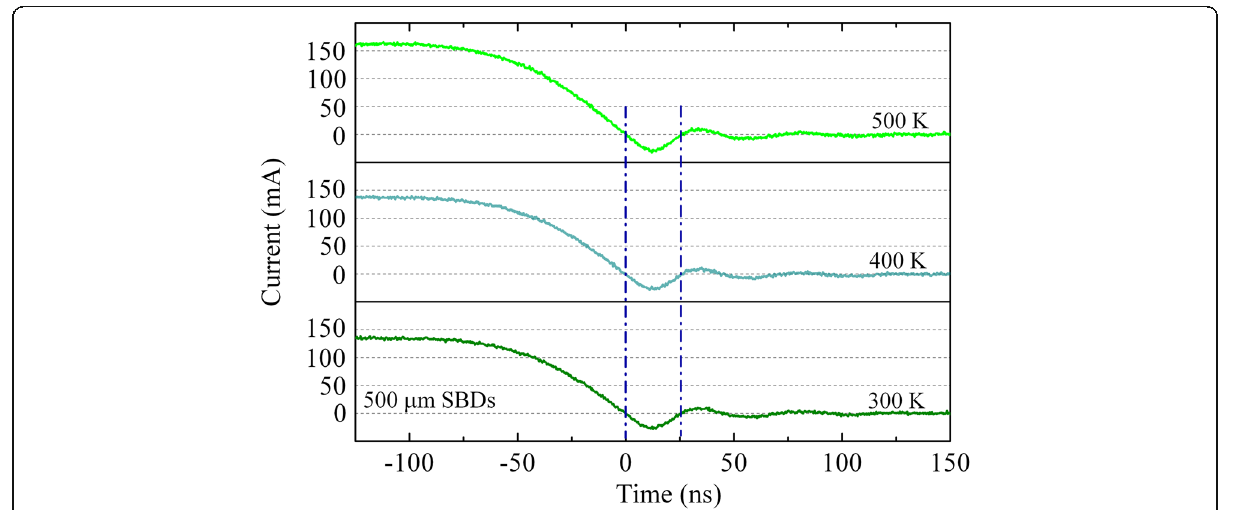
Fig. 7 Reverse recovery characteristics for 500- μ m-diameter SBDs measured at 300, 400, and 500 K,